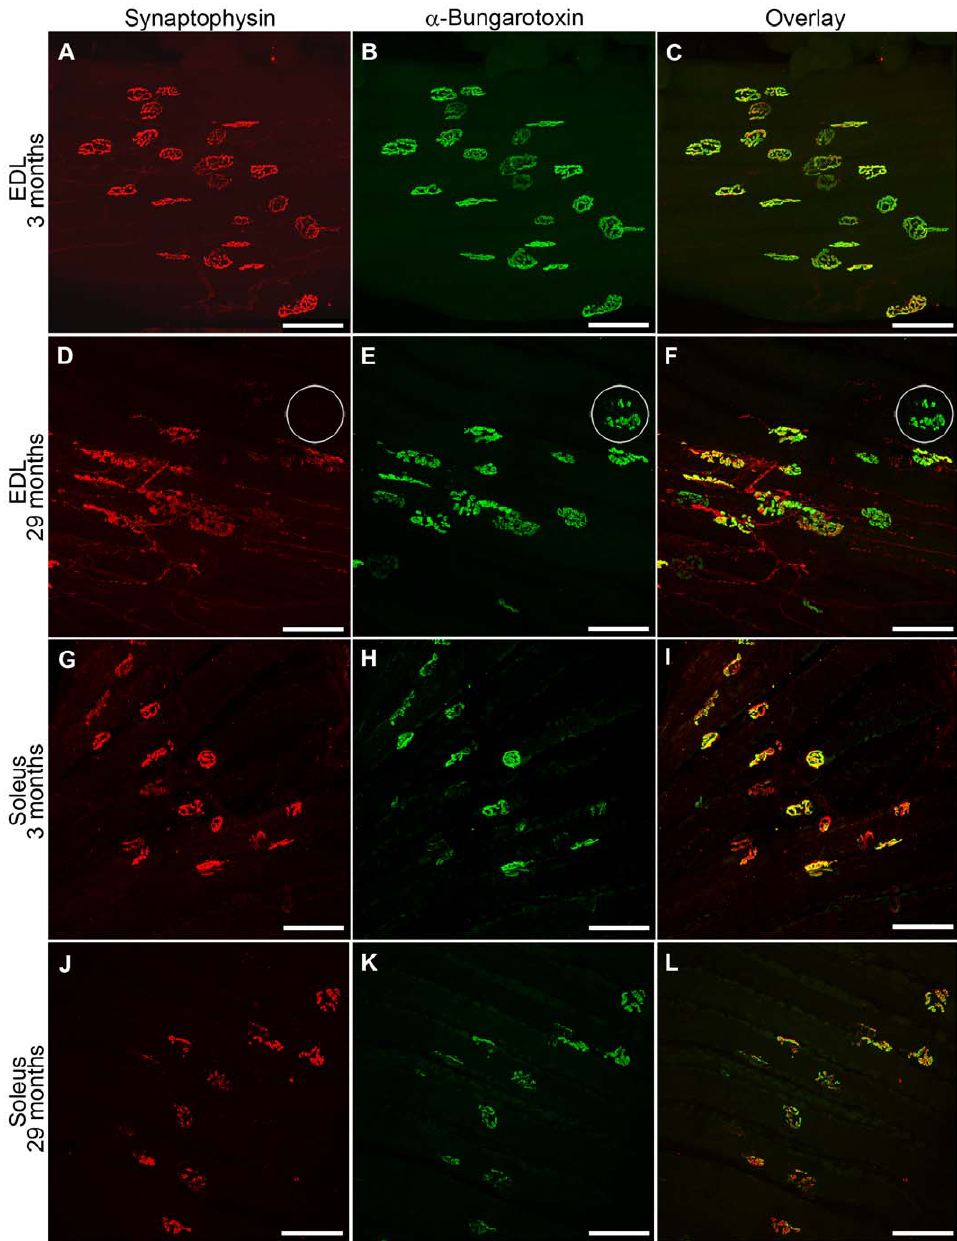
Figure 2. Whole mount immunohistochemical preparations of EDL (A–F) and soleus (G–L) muscles from 3 and 29 month old mice. Muscles were stained with synaptophysin (A,D,G,J; red) to detect pre-synaptic neuronal compartments and with a -bungarotoxin (B,E,H,K; green) to detect acetylcholine receptors at the muscle endplates. Overlays are shown in (C,F,I,L; yellow). Muscle endplates that are positive for only a - bungarotoxin (green) are not innervated. One such endplate is indicated (white circle) in the 29 month old EDL (D,E,F). NMJs in the 3 month old EDL appear compact and well defined (A–C), while many NMJs have a diffused, irregular and fragmented appearance in the 29 month old EDL (D–F). In contrast, the NMJs in soleus of geriatric mice (J–L) did not show morphological changes when compared to 3 month old NMJs (G–I). Scale bars are 75 m m.